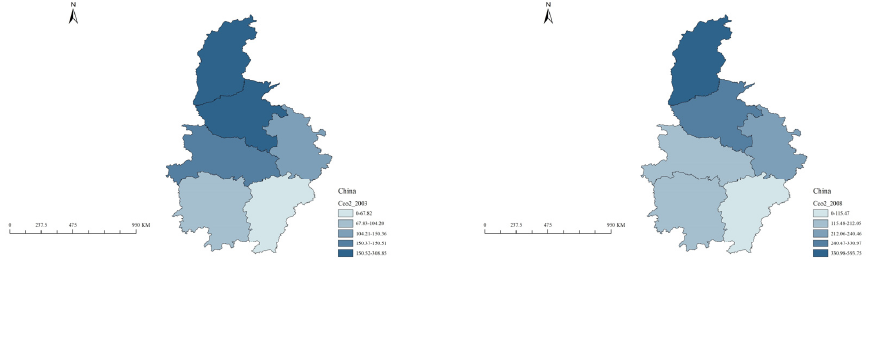
Figure 7. The trend of carbon emission levels in eastern China.